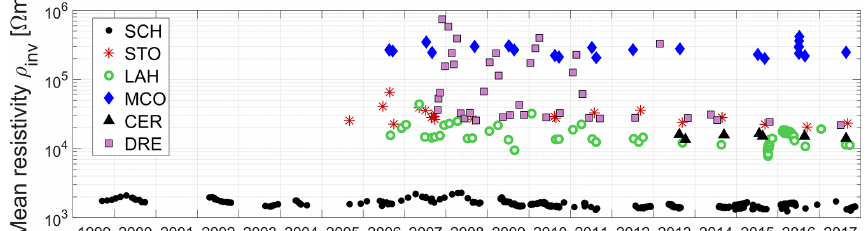
Figure 3. Overview of the available ERTM time series for the six stations of the network and comparison of their spatial mean